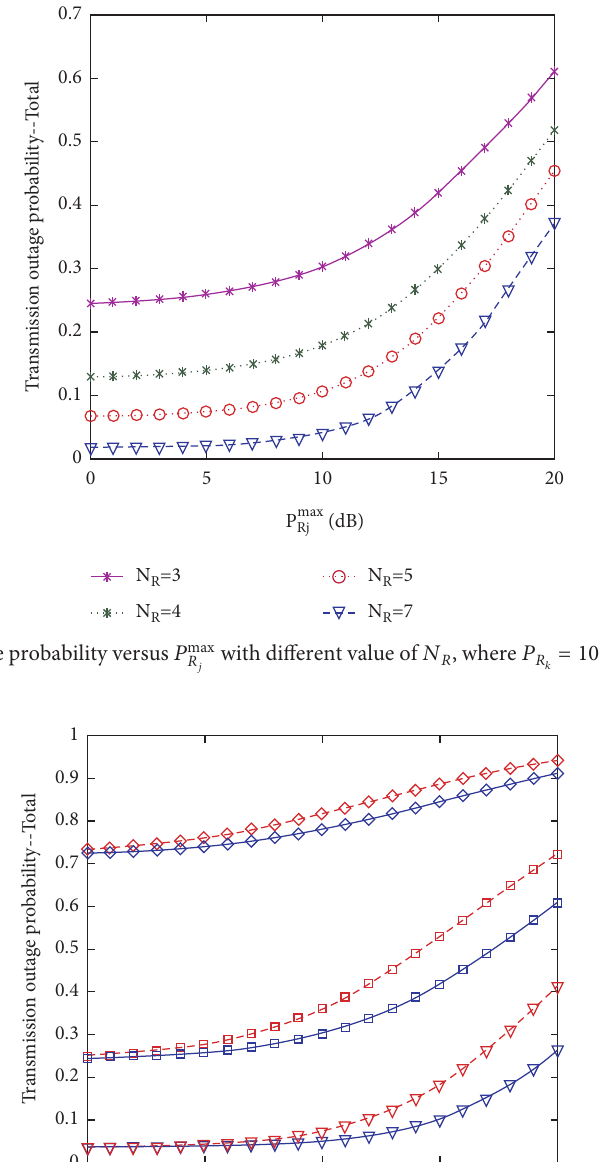
R , where P � 10 dB , P � 10 dB , N � 3, R k A R